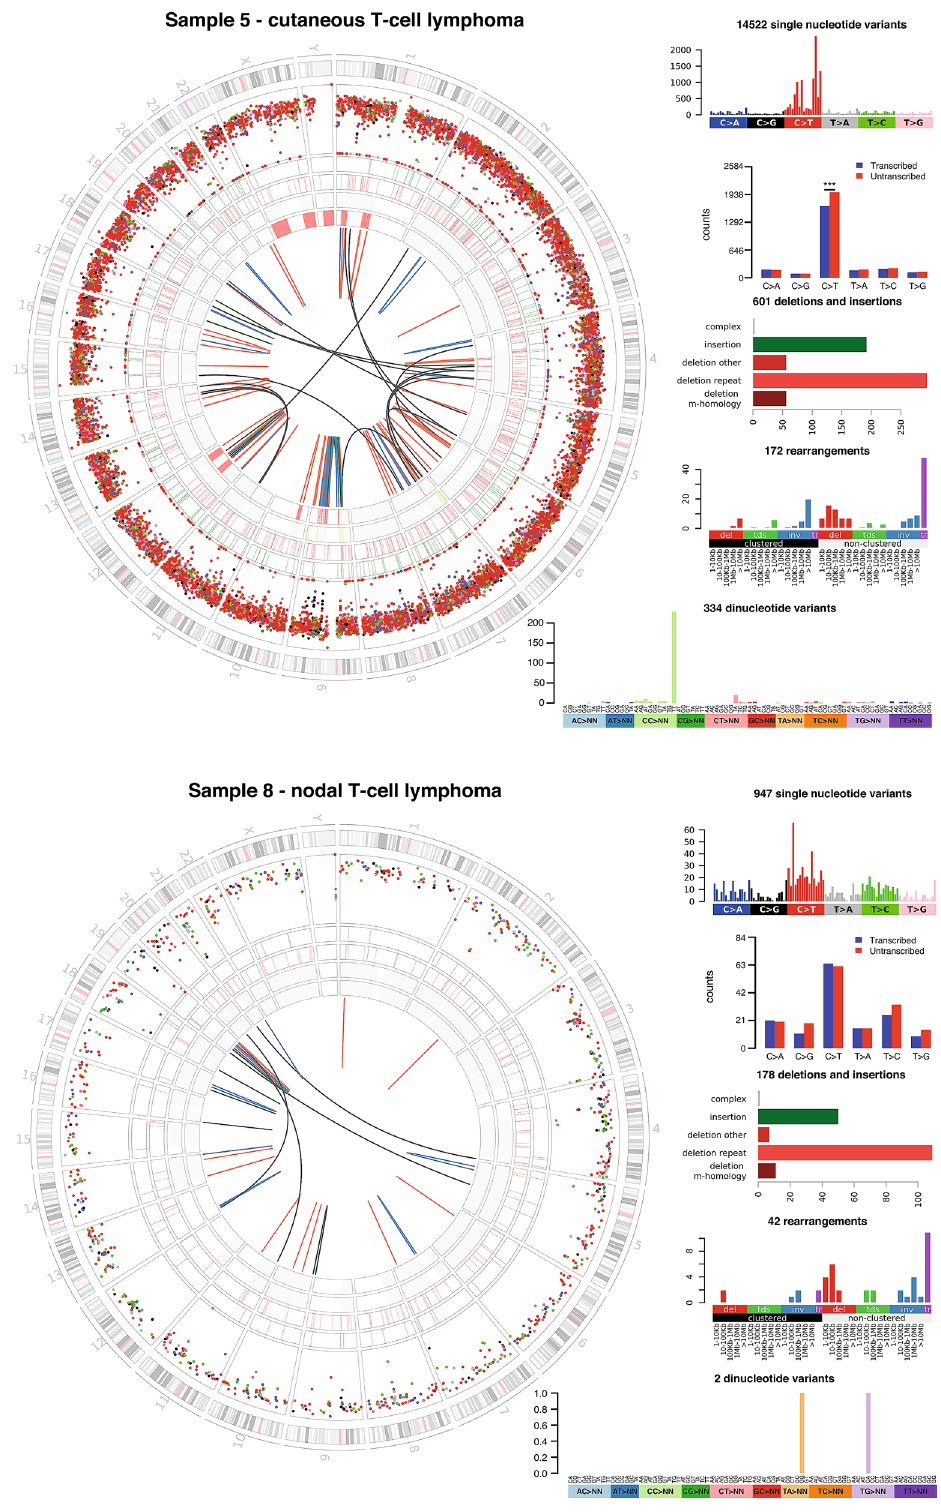
Figure 5. Characteristic features of UV induced mutation are observed only in patients with cutaneous T-cell lymphoma. Whole genome sequencing data from the UK 100,000 genomes project comparing representative cutaneous and nodal T-cell lymphoma patients. The highlighted track on the circos plots is a rainfall diagram of SNVs where distance from the centre is proportional to the logarithm of the distance between adjacent SNVs. Cutaneous T-cell lymphoma patients have a characteristic inner ring of C>T variants due to CC>TT substitutions, which are also clear in the light green bar on the dinucleotide variants plot. Single nucleotide variants occurring within gene bodies were assessed to determine whether they affect the transcriptional or non-transcriptional strand. Significant transcriptional strand bias was observed for C>T mutations in cutaneous T-cell lymphoma but not nodal T-cell lymphoma indicating transcription-coupled nucleotide excision repair, a feature of UV induced